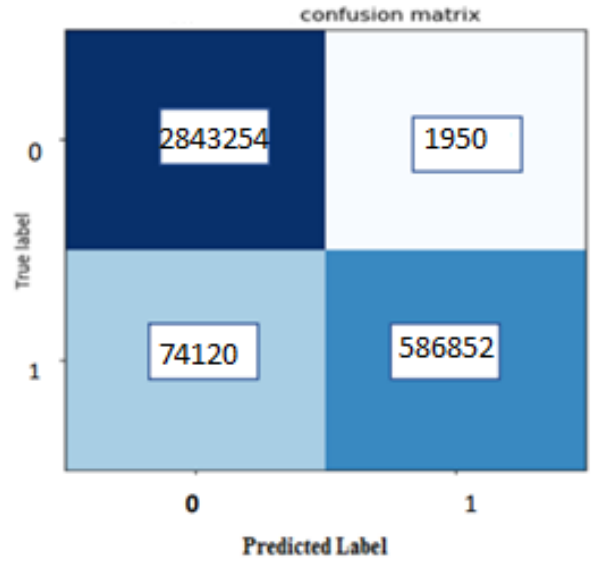
Figure 15. Confusion Matrix for the proposed method. Table 1. Comparison of proposed network performance and the state-of-the-art alternatives on LIDC-IDRI dataset.